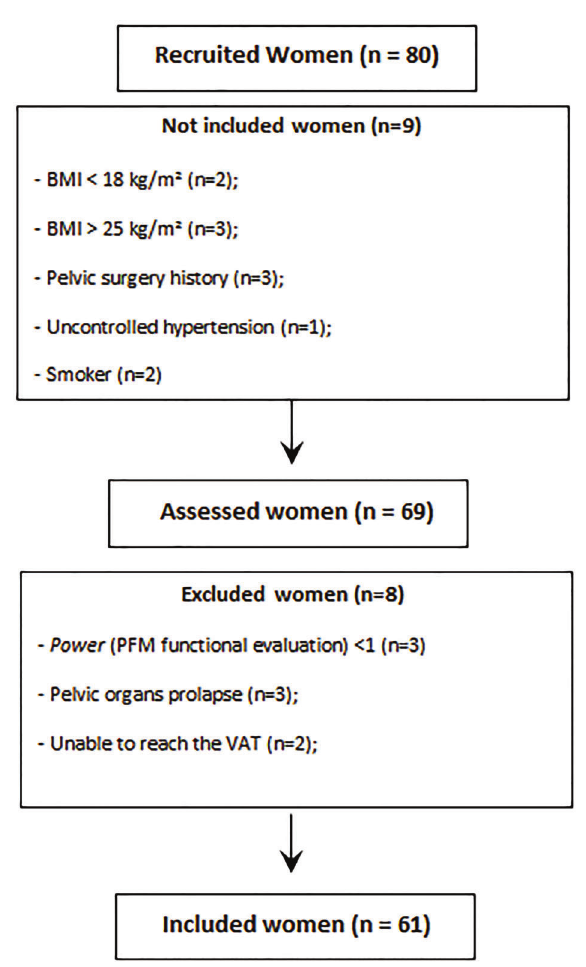
Figure 1. Flowchart of the participants recruited for the present study. BMI: body mass index; PFM: pelvic fl oor muscles; VAT: ventilatory anaerobic threshold. Twenty of these women were only recruited to evaluate the reliability of the reference